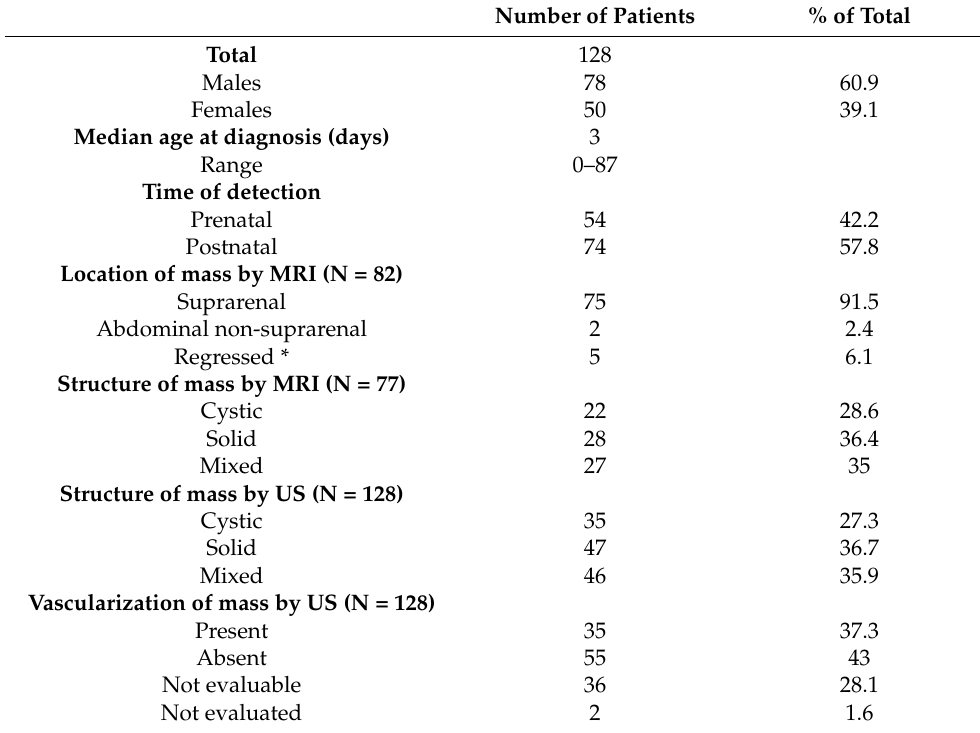
Table 2. Patient